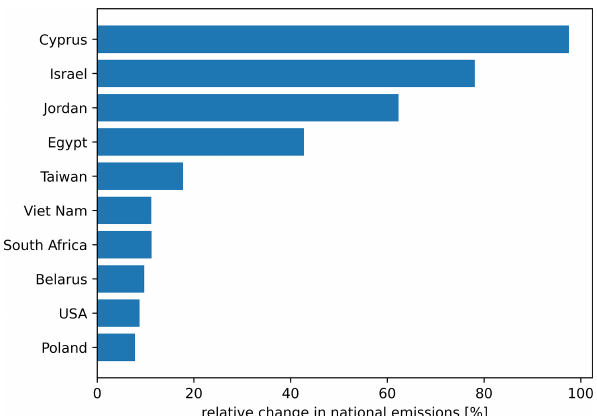
Figure A4. Relative change in national a posteriori emissions of selected countries, when flask measurements are used in addition to contin- uous measurements in the case of 50d